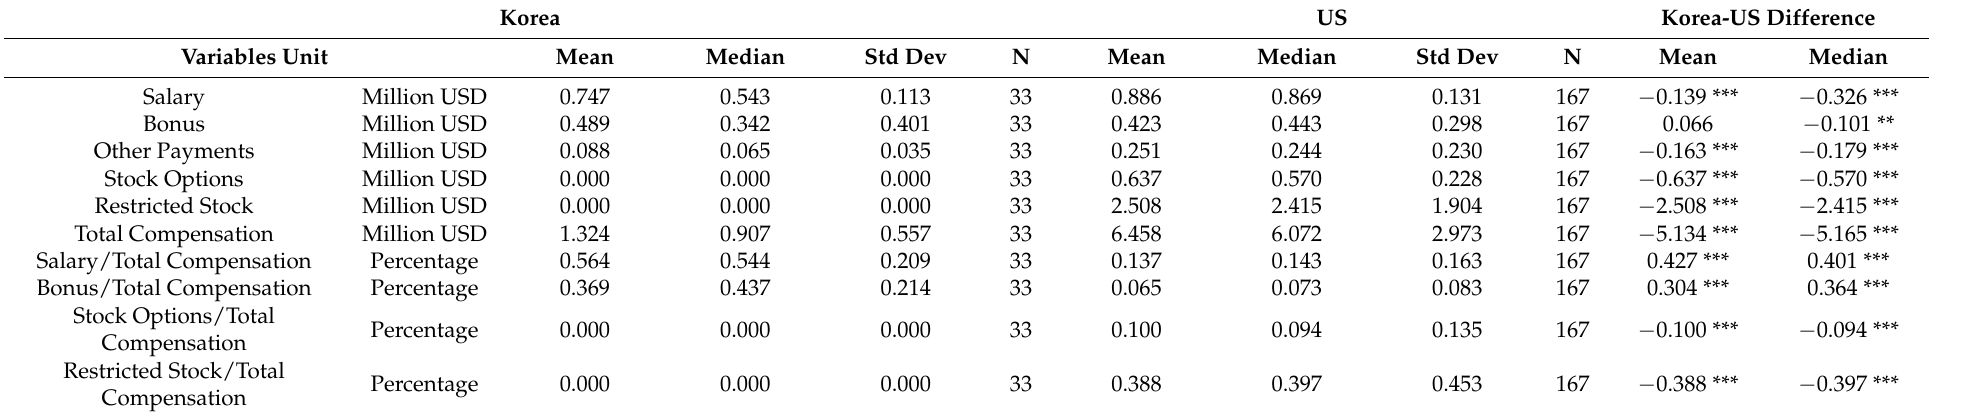
Table 6. Korea-US Comparison: Level and Structure of CEO